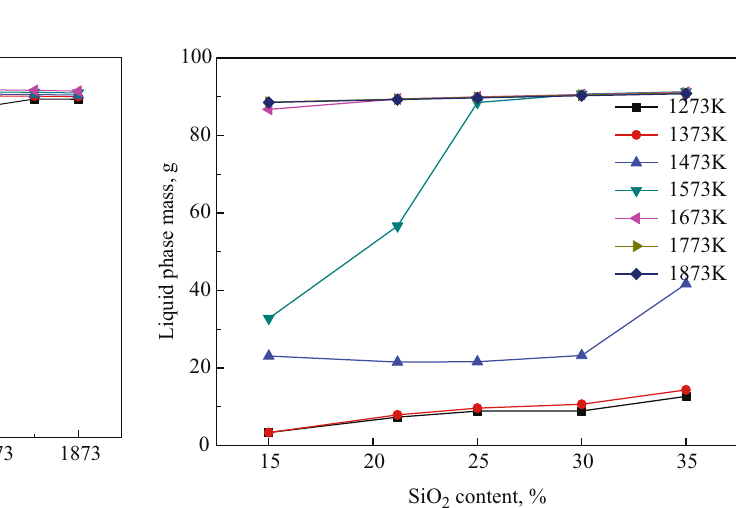
Figure 16: Relationship between liquid production and SiO 2 content at di ff erent